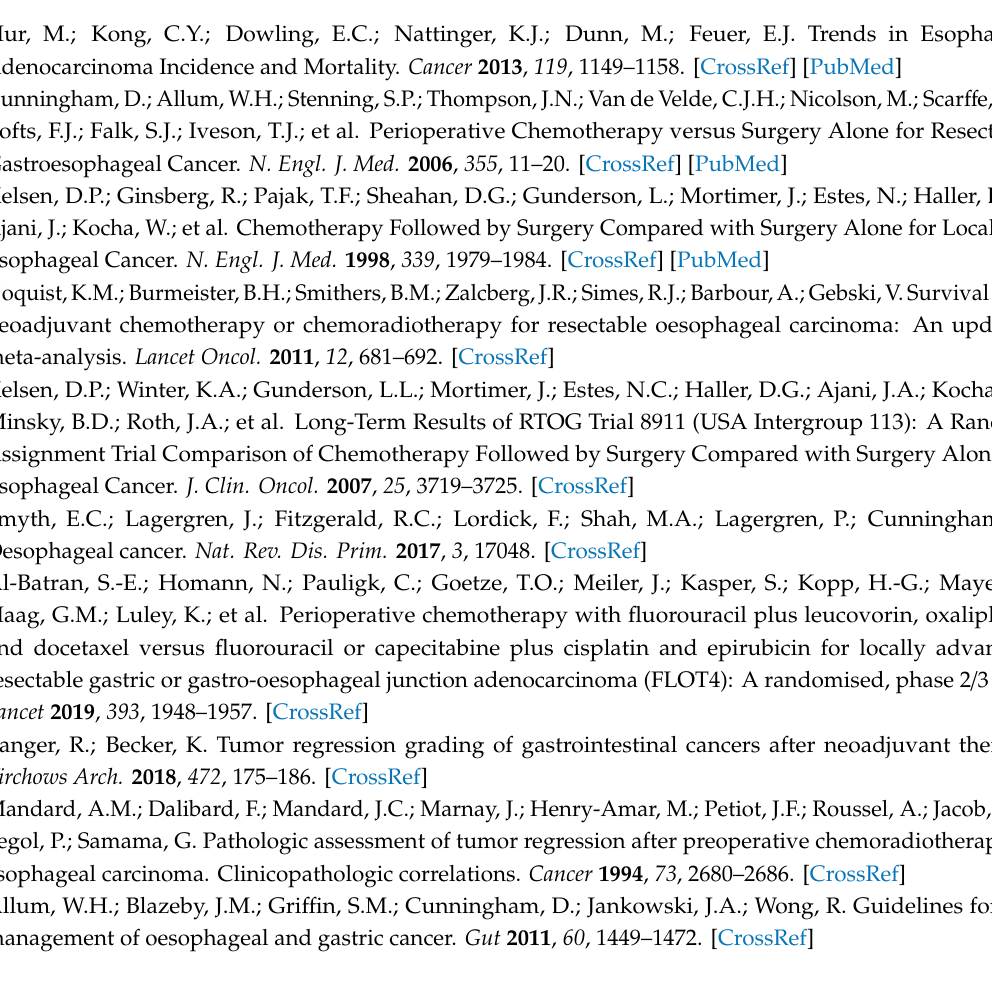
Figure S1: No di ff erence in levels of serum proteins was observed between low and high TRG groups, Figure S2: Serum proteins were not significantly associated with OS time, Figure S3: Serum protein levels were not altered between node negative and node positive groups, Figure S4: Serum protein levels were not altered between recurrence and no recurrence groups, Figure S5: Levels of serum marker expression before and after neo-CT treatments, Figure S6: Serum protein levels were not altered between lymphocyte high and low tumor